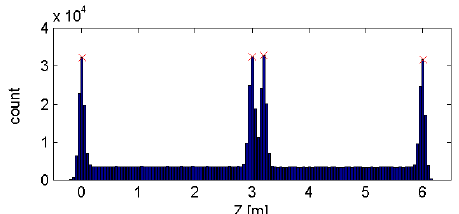
Figure 4. The histogram of z coordinates showing distinct peaks corresponding to the two storeys of the building.